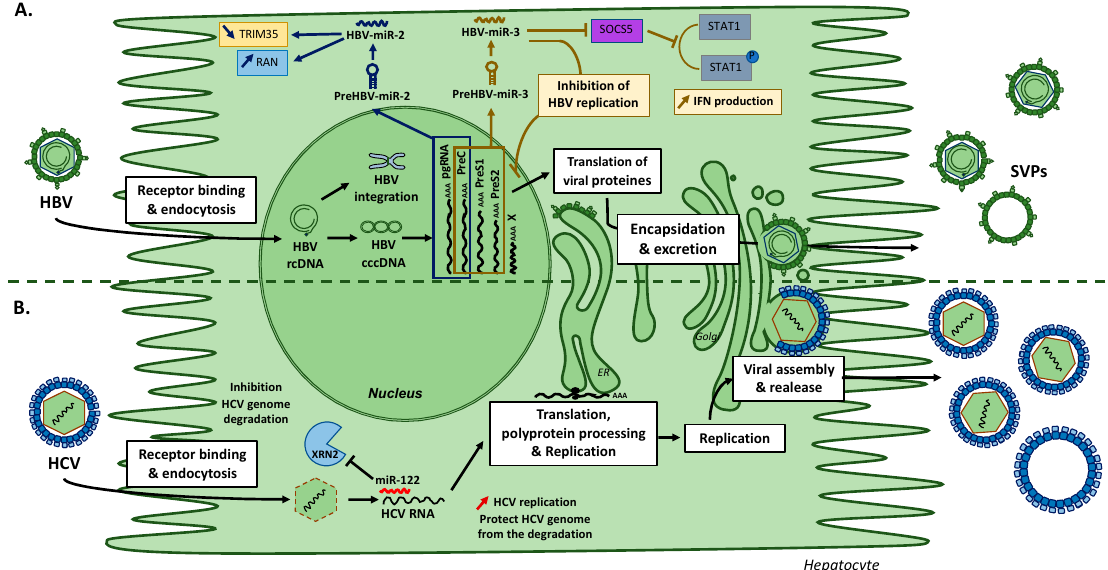
Figure 3. HBV-encoded miRNAs production and their targets ( A ), and modulation of HCV replication by miR-122 ( B ). ( A ) HBV encodes for two different miRNAs: HBV-miR-2 and HBV-miR-3. HBV-miR-2 is encoded from HBV pgRNA and HBV-miR-3 from PreC, PreS1 and PreS2 mRNAs. HBV-miR-2 down-regulates TRIM35 and up-regulates RAN expressions. HBV-miR-3 represses SOCS5 and PPM1A expression to increase interferons. Moreover, HBV-miR-3 regulates HBV core proteins (HBc) and the level of pgRNA. ( B ) Mode of actions of miR-122 on HCV replication and maintenance. miR-122 binds to HCV RNA genome and protect HCV against the degradation by exoribonucleases and promote HCV replication. HBV = Hepatitis B virus; HCV = Hepatitis C virus; TRIM35 = Tripartite motif-containing protein 35; PPM1A = Protein phosphatase 1A; RAN = Ras-related Nuclear protein; rcDNA = relaxed circular DNA; cccDNA = covalently closed circular DNA; SOCS5 = Suppressor of cytokine signaling 5; STAT1 = Signal transducer and activator of transcription 1; SVPs = Subviral Particles; XRN2 = 5 ′ -3 ′ exoribonuclease 2.